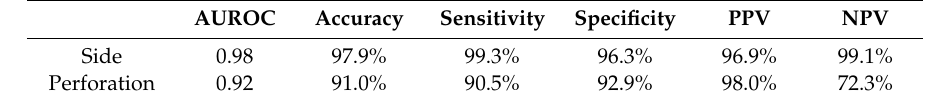
Table 2. Diagnostic performance of the